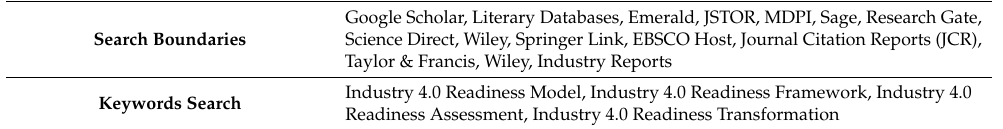
Table 1. Search boundaries and keywords.